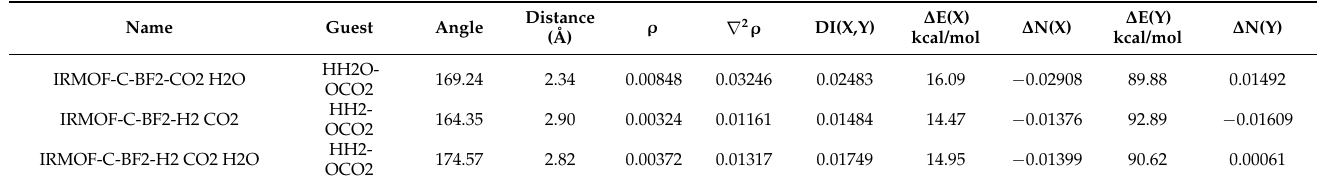
Table 2. Topological parameters of the BCP of bond in adsorption configurations of guest molecules (CO 2 , H 2 O and H 2 ) on IRMOF-C-BF 2 . Guest intermolecular interactions.